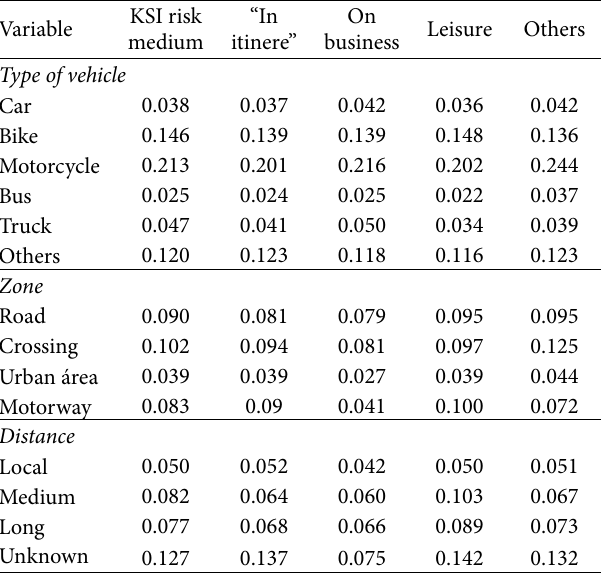
Table 2: Probabilities of suffering a serious accident, depending on the type of displacement and the different variables of the human factor. Processed by the authors.